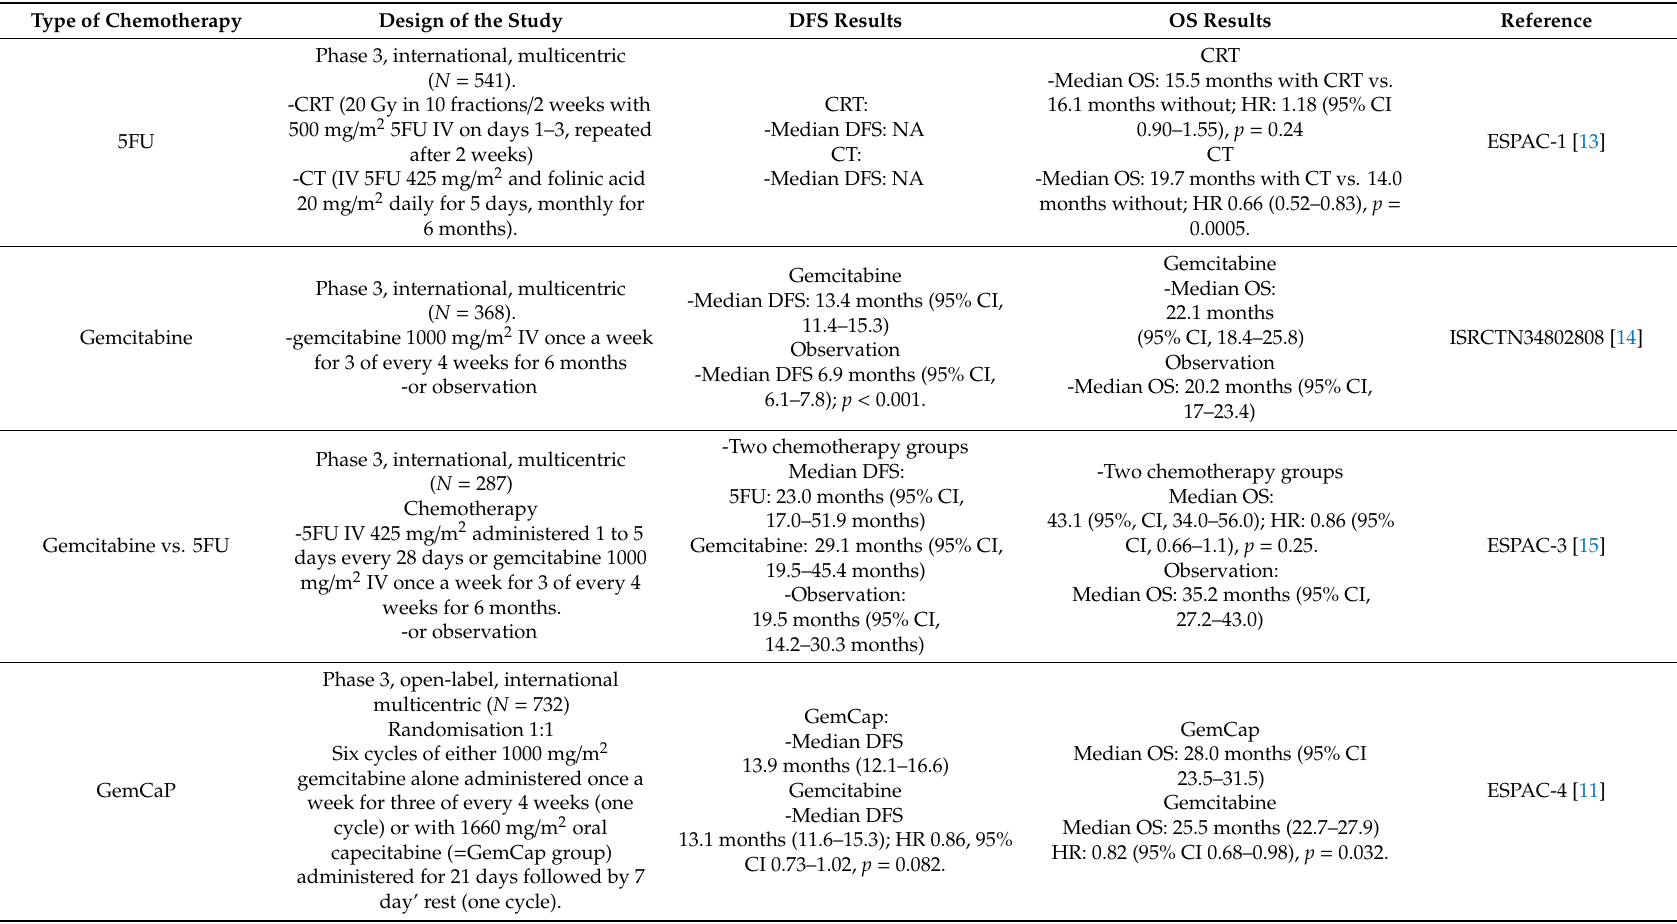
Table 1. Main Phase III studies evaluating adjuvant chemotherapy